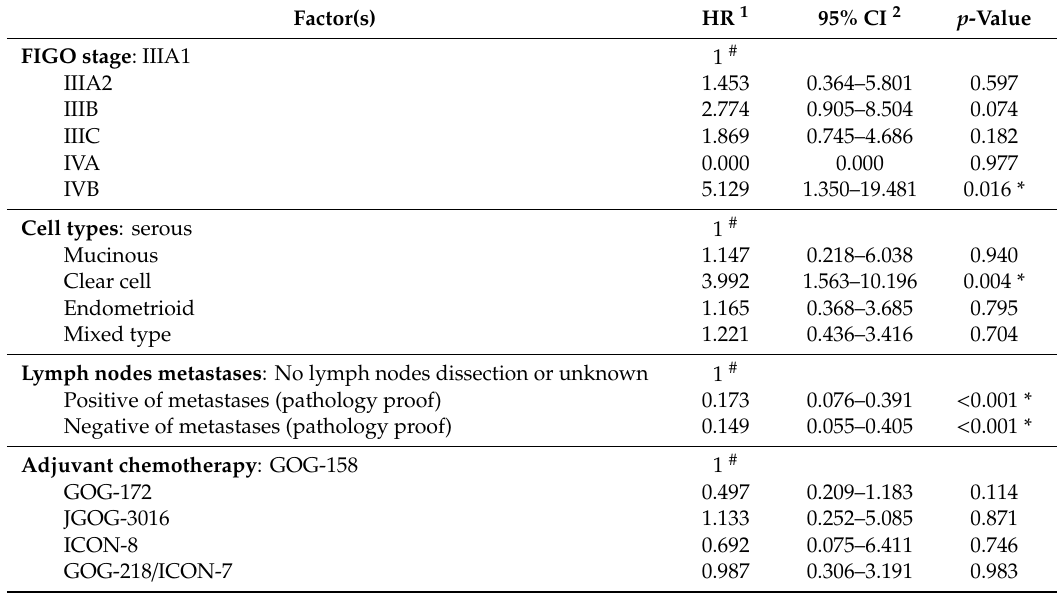
Table 10. Cox regression hazard model for disease recurrence / persistence in optimally debulked cases.